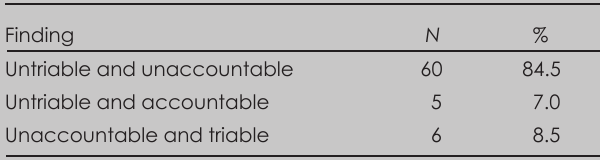
Table II. Findings regarding accountability and triability ( N = 71) Finding N % Untriable and